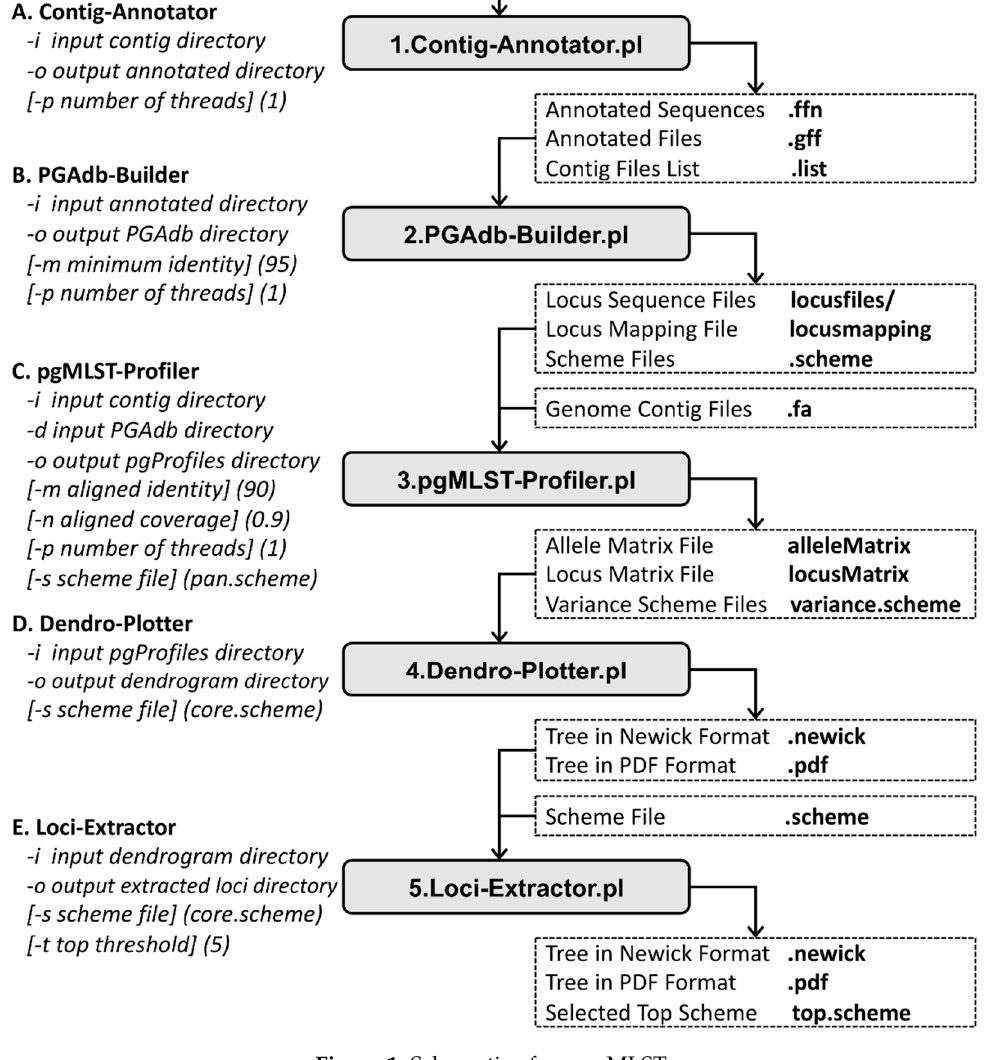
Figure 1. Schematic of cano-eMLST. Table 1. The Loci Extractor pseudocode.